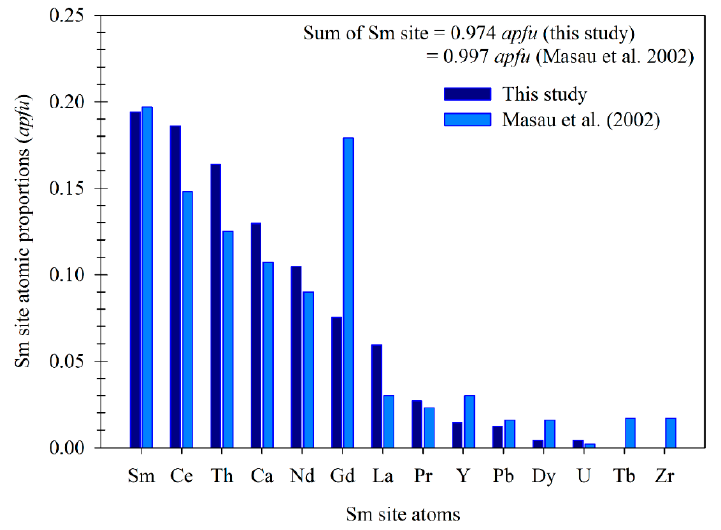
Figure 6. Atoms at the Sm site in sample 4a [monazite-(Sm)] and monazite-(Sm) in Masau et al. [54]. The main difference is in the amount of Gd atoms in the two samples.